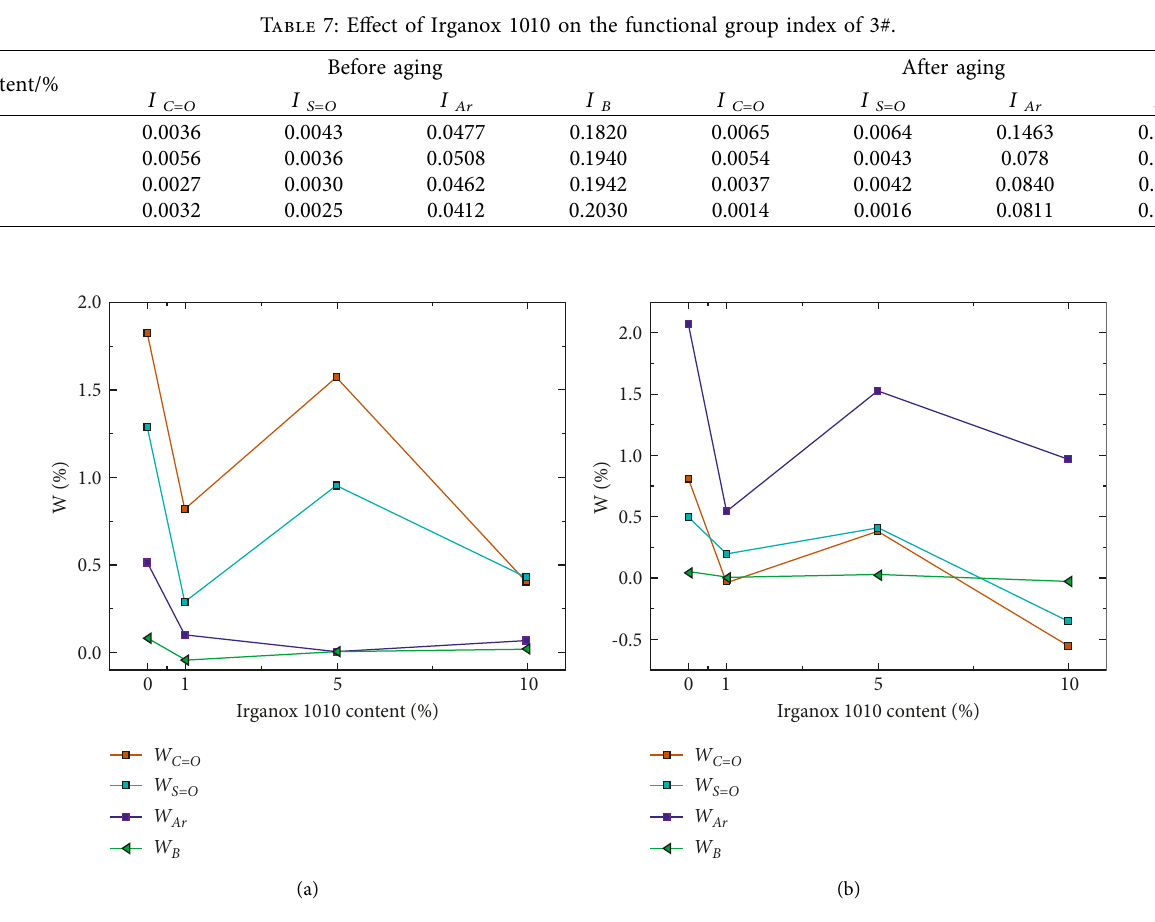
Figure 16: Effect of Irganox 1010 on (W) (a) 1# (b) 3#.